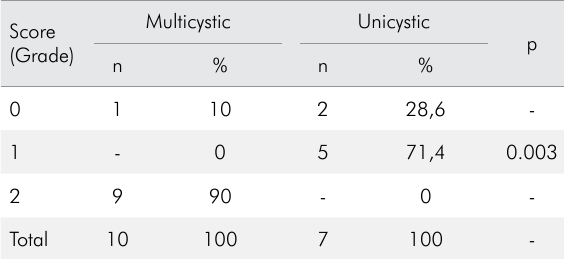
Table 2. Diferences in CD90 expression in multicystic and unicystic